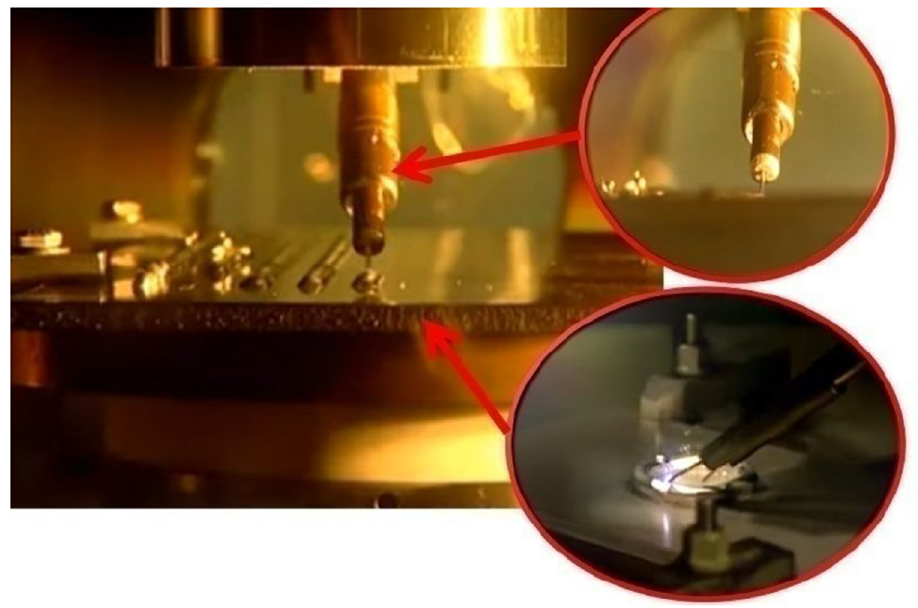
Figure 13. Electron beam freeform fabrication technique showing the first layer building in the layer-by-layer process [104].